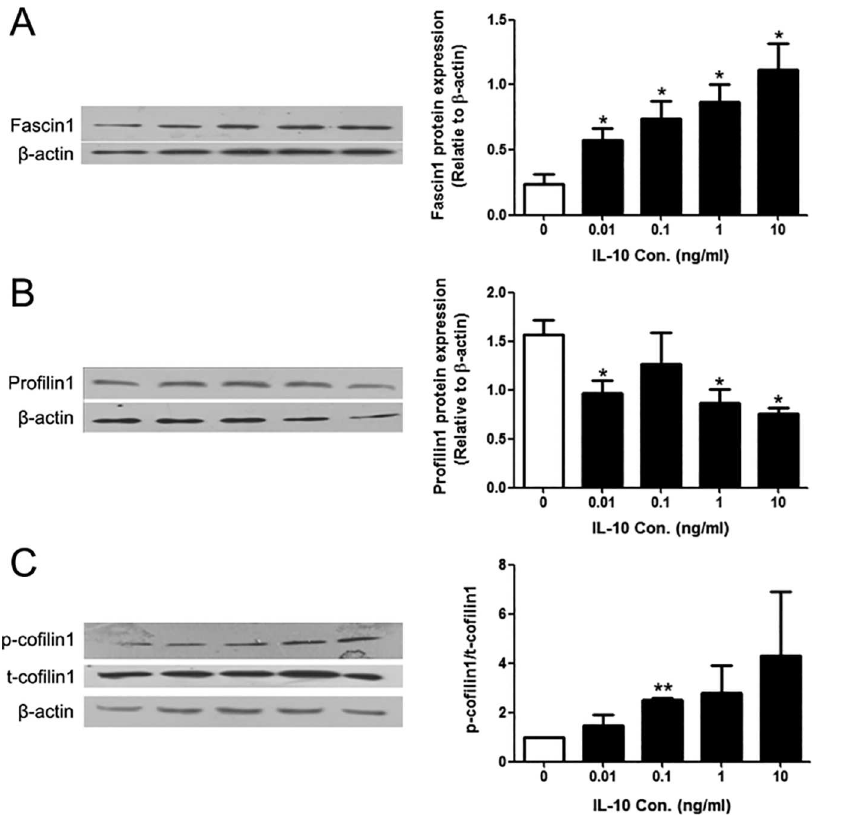
Fig 4. The effects of IL-10 on the expressionlevels of some actin-binging proteins in mDCs. (A) Representative Western blot image of fascin1 (left panel)and the quantitativedata (right panel). (B) Representative Western blot image of profilin1(left panel)and the quantitativedata (right panel).(C) Representative Western blot image of p-cofilin1, total cofilin1(left panel)and the quantitative data (right panel). β -actinwas used as the internalcontrol. Comparedwith control group: * p < 0.05, ** p < 0.01.